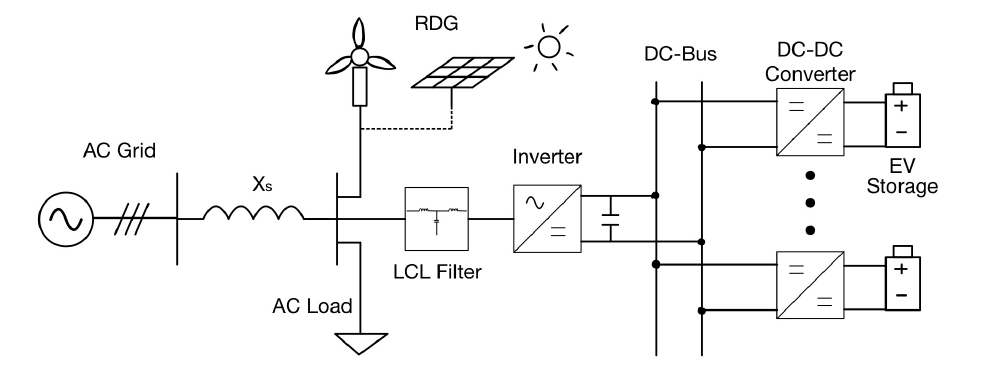
Figure 2. Schematic EV DC-Bus